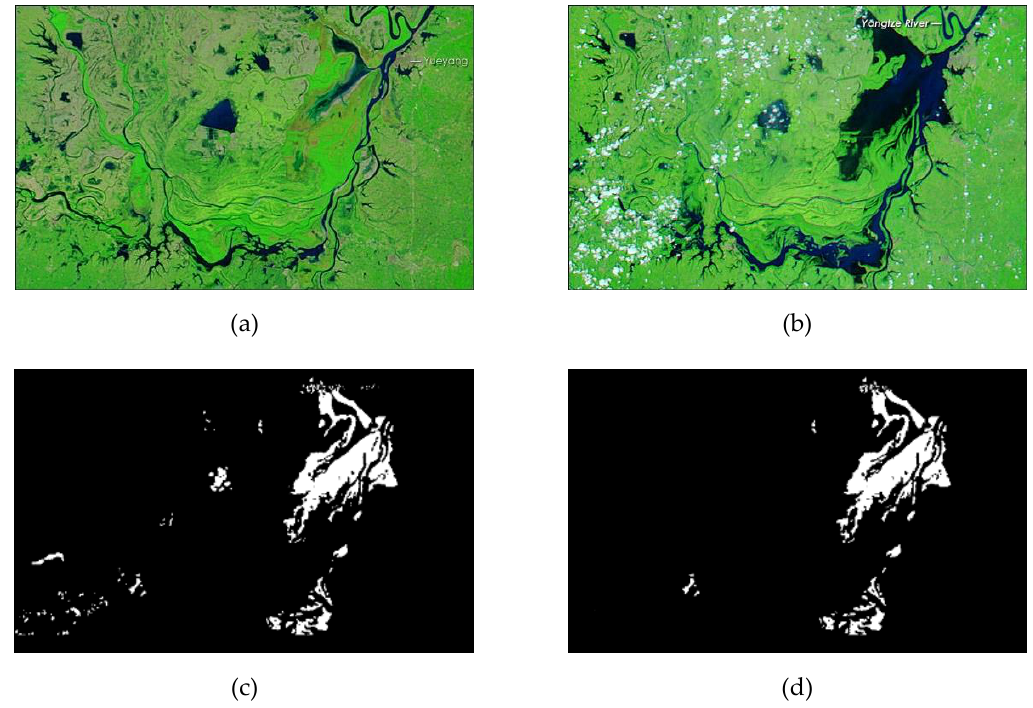
Figure 7. Changes in the different seasons of Dongting Lake. ( a ) image in dry season, ( b ) rainy season image, ( c ) change detection results, and ( d ) Results after cloud elimination.